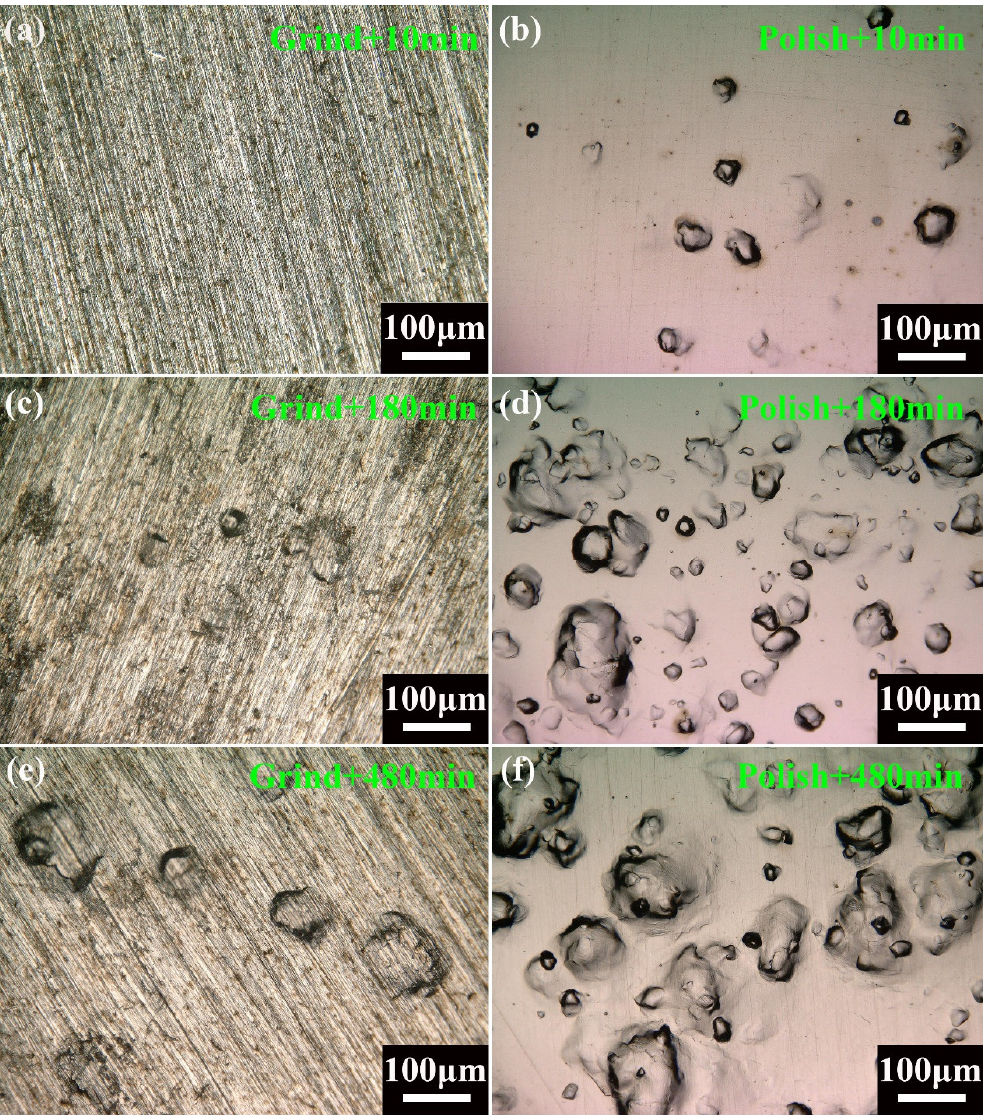
Figure 5. Hydrogen blisters of grinded and polished surfaces at various hydrogen charging times: ( a , b ) 10 min; ( c,d ) 180 min and ( e,f ) 480 min.